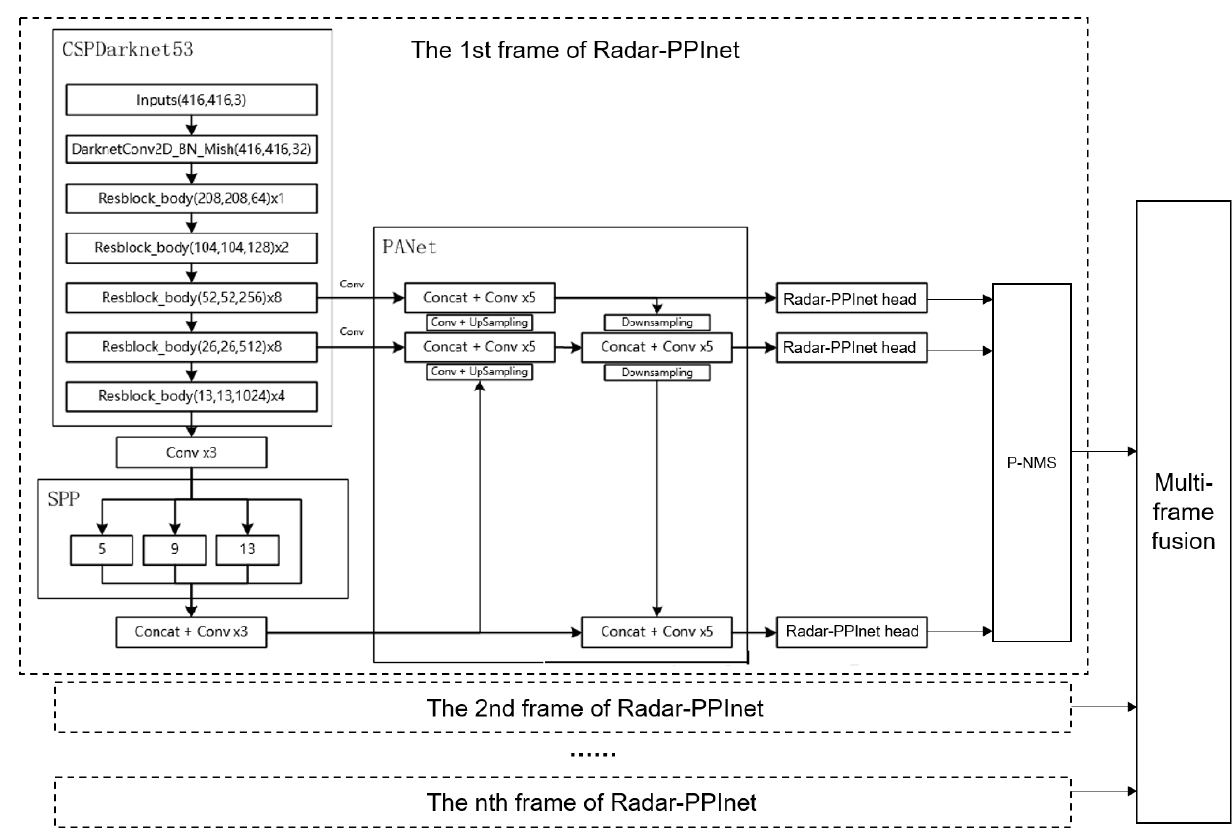
Figure 5. The structure of the proposed